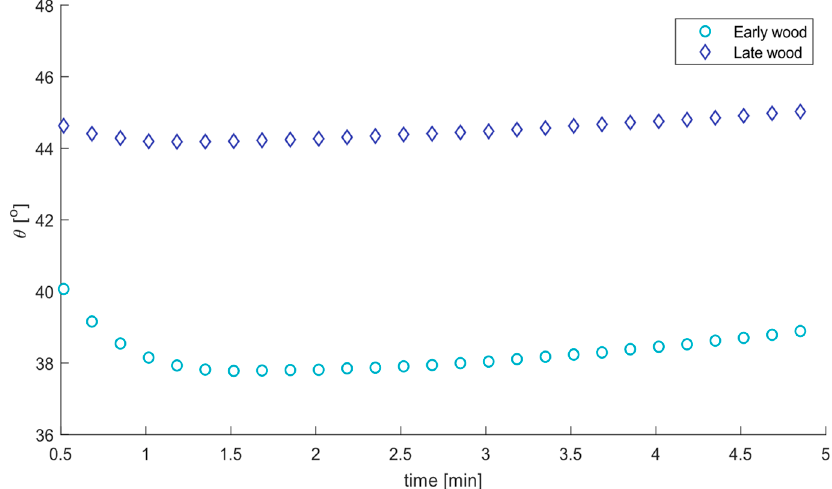
Figure 10. Time evolution of S.W.-1 coating contact angle of on wood substrate.